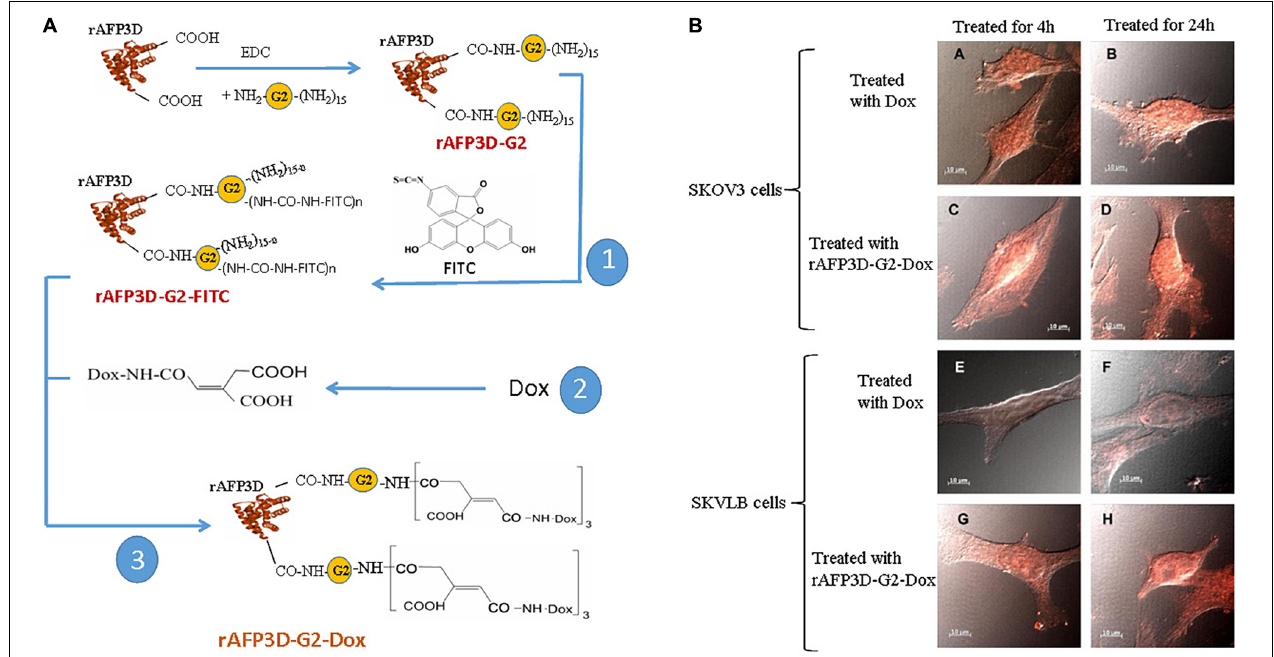
FIGURE 5 | Scheme of conjugate synthesis of rAFP3D-G2-Dox and the accumulation of doxorubicin (Dox) in the drug-sensitive human ovarian adenocarcinoma SKOV3 cell line and the drug-resistant human ovarian adenocarcinoma SKVLB cell line. (A) rAFP3D conjugated to Dox (rAFP3D-G2-Dox). (B) Intracellular distribution of rAFP3D-G2-Dox and free Dox in (A ∼ D) the drug-sensitive human ovarian adenocarcinoma SKOV3 cell line and (E ∼ H) the drug-resistant human ovarian adenocarcinoma SKVLB cell line. Reprinted from Yabbarov et al. (2013) with permission from